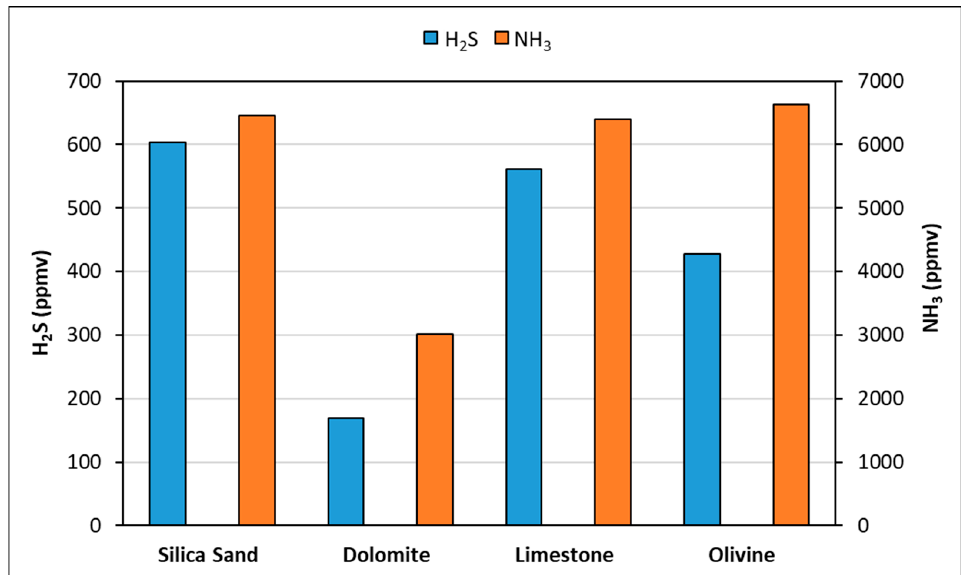
Figure 5. Effect of the catalyst type on NH 3 and H 2 S concentrations in the syngas produced by WST gasification at 800 °C, ER = 0.13, steam/lignin = 0.35 g/g(daf); ppmv, parts per million in volume.